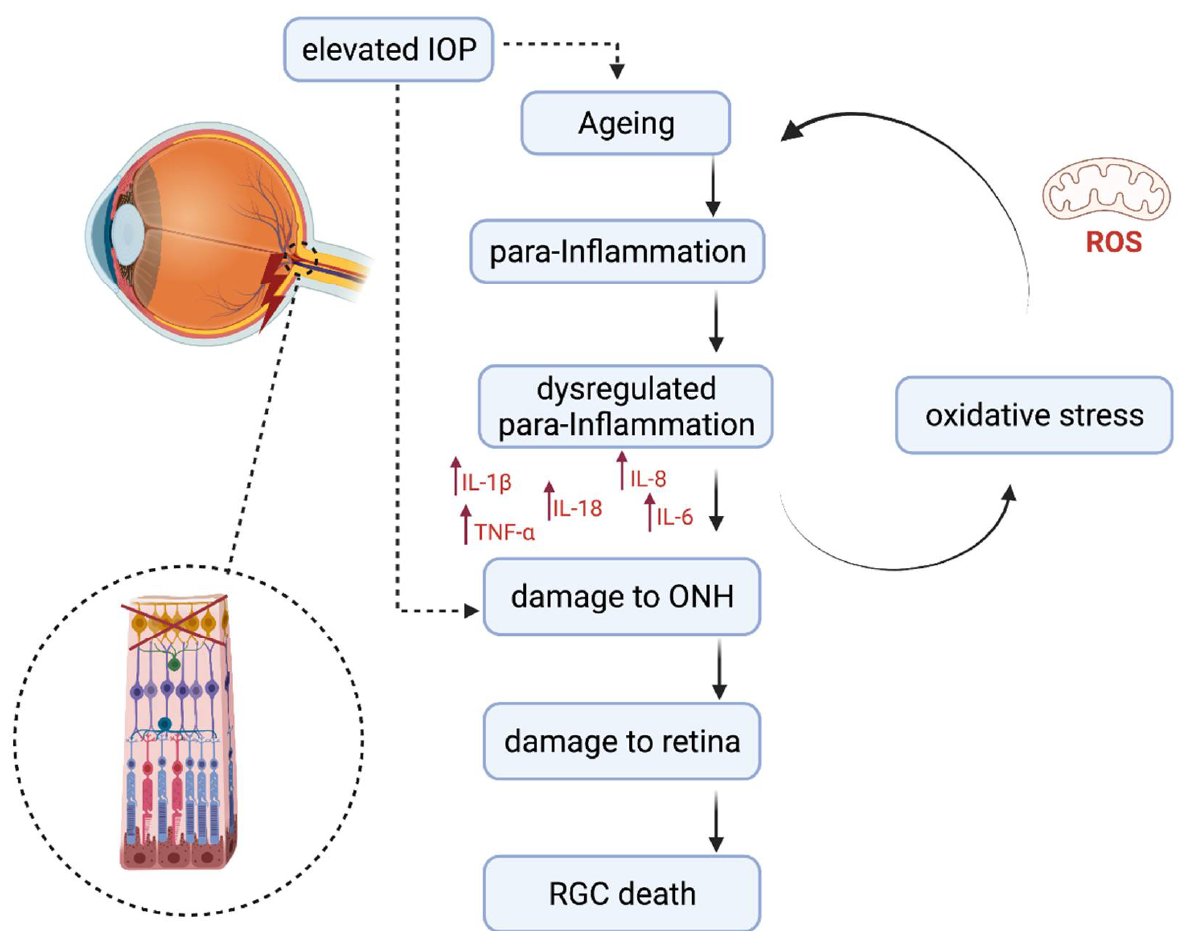
Figure 1. Aging and para-inflammation contributes to retinal ganglion cell death. Ageing in the retina due to ROS is thought to activate a para-inflammatory response, which can become dysregulated and result in damage to the ONH and retina and subsequently RGC death ROS—reactive oxygen species; RG—retinal ganglion cells; ONH—optic nerve head.